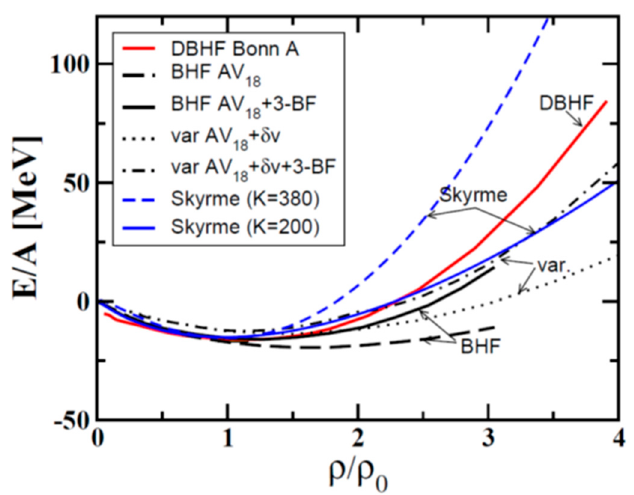
Figure 2. The equation of state for symmetric nuclear matter for soft and hard Skyrme forces and from microscopic ab-initio calculations [8].